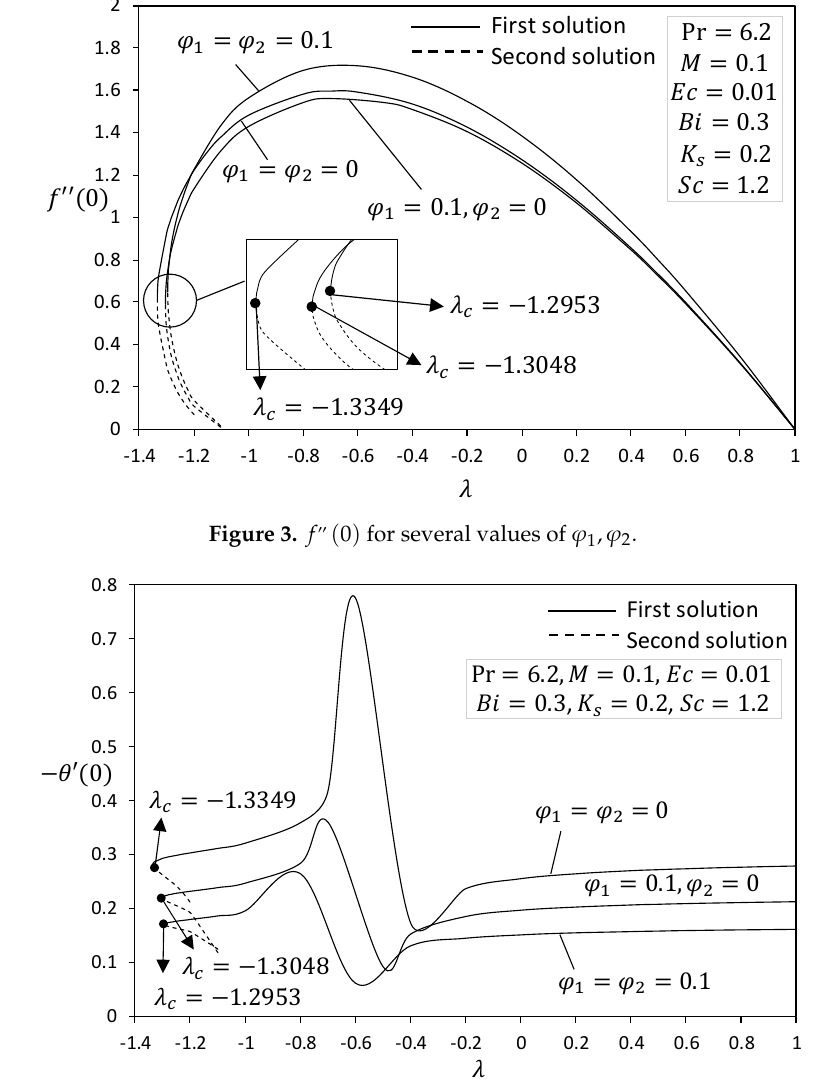
, ϕ ϕ . 1 2 , ϕ ϕ . 1 2